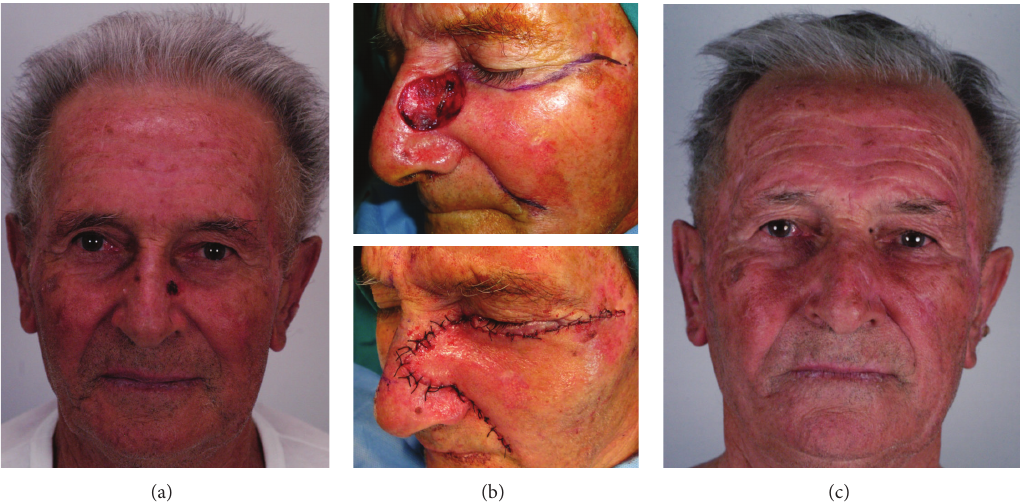
Figure 2: Patient no. 8 showed in Table 1. (a) Basal cell carcinoma of the left nasal sidewall and infraorbital unit; (b) (intraoperative view) 3 × 3.2 cm defect after tumor resection. Advancement cheek flap is marked (up). Flap inset (down). (c) Final result 6 months after